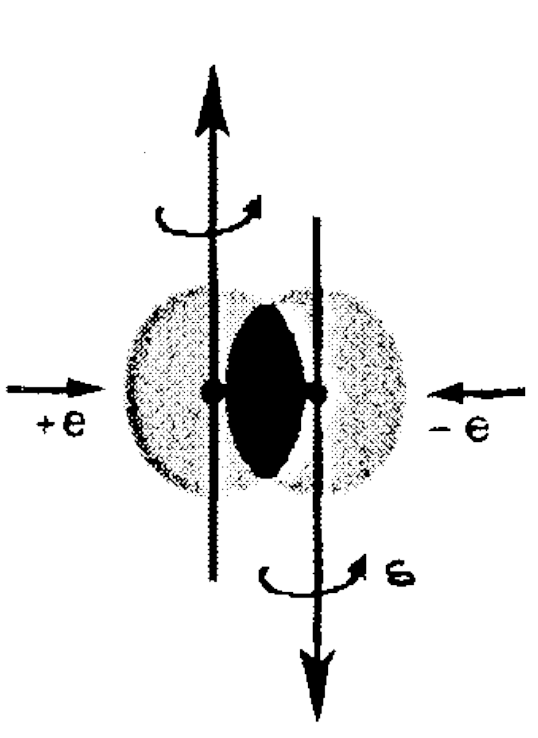
Figure 20: According to the basic principles of quantum mechanics and chemistry, elec- tron valence pairs in molecular structures should “repel” (rather than “attract”) each other with a force of the order of 230 N , Eq. (107), which is extremely big for particle standards. Hadronic mathematics, mechanics and chemistry have achieved an attractive force between valence electron pairs so strong to turn them into a quasi-stable particle called the isoelectronium [30], that allowed the first known achievement of exact repre- sentation of experimental data on the hydrogen [52] and water [53] molecules that are not possible with quantum chemistry. In Santilli’s view, the impossibility in quantum chem- istry to achieve an attractive force between valence electron pairs as occurring in nature, is additional evidence supporting the need for the “completion” of quantum principles into covering vistas according to Einstein’s